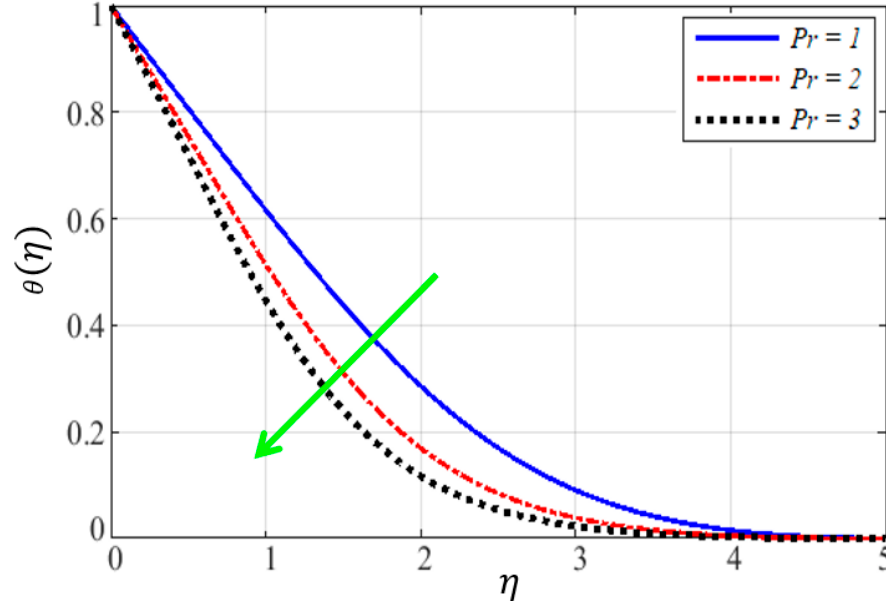
Figure 10. Impact of Prandtl number on temperature fi eld.